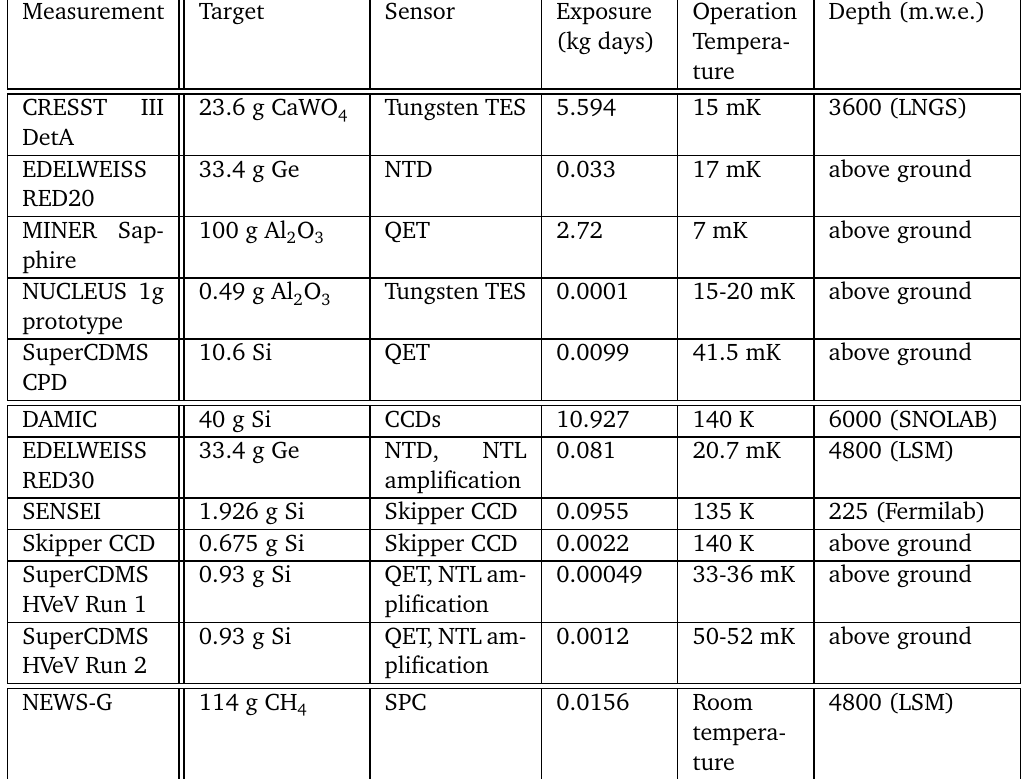
Table 1: Key properties of the measurements presented at the EXCESS